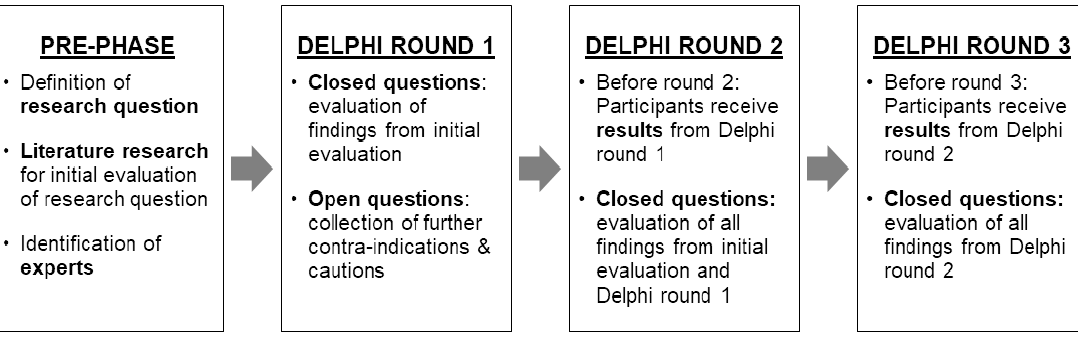
Figure 3. Rounds of the Delphi process.